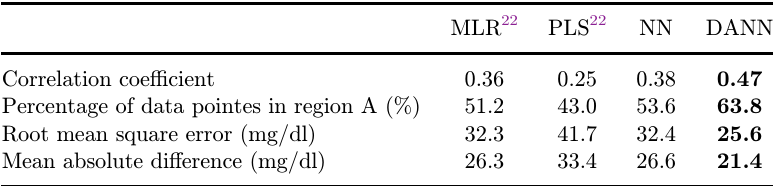
Table 4. Comparison of